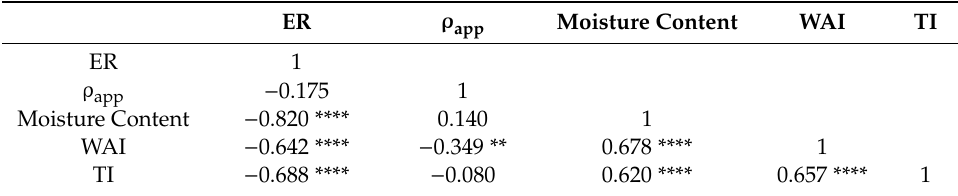
Table 5. Correlation coe ffi cients among the expansion ratio, apparent density, water absorption index, moisture content, and texturization index. ER ρ app Moisture Content WAI